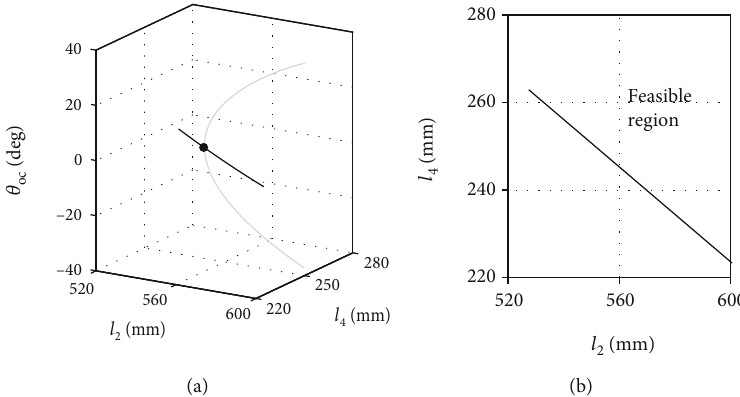
Figure 11: Bifurcation point SN variation under two-parameter continuation.